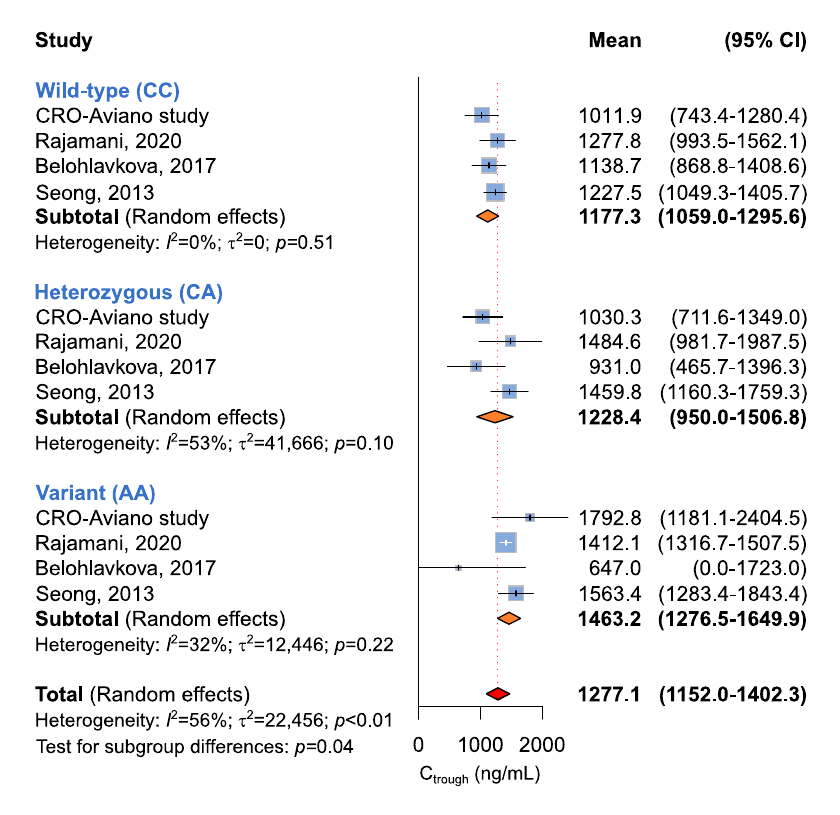
Figure 5. Forrest plots for the association between ABCG2 c.412C>A and imatinib C trough levels for individual genotypes (allelic model) [14,16,19].